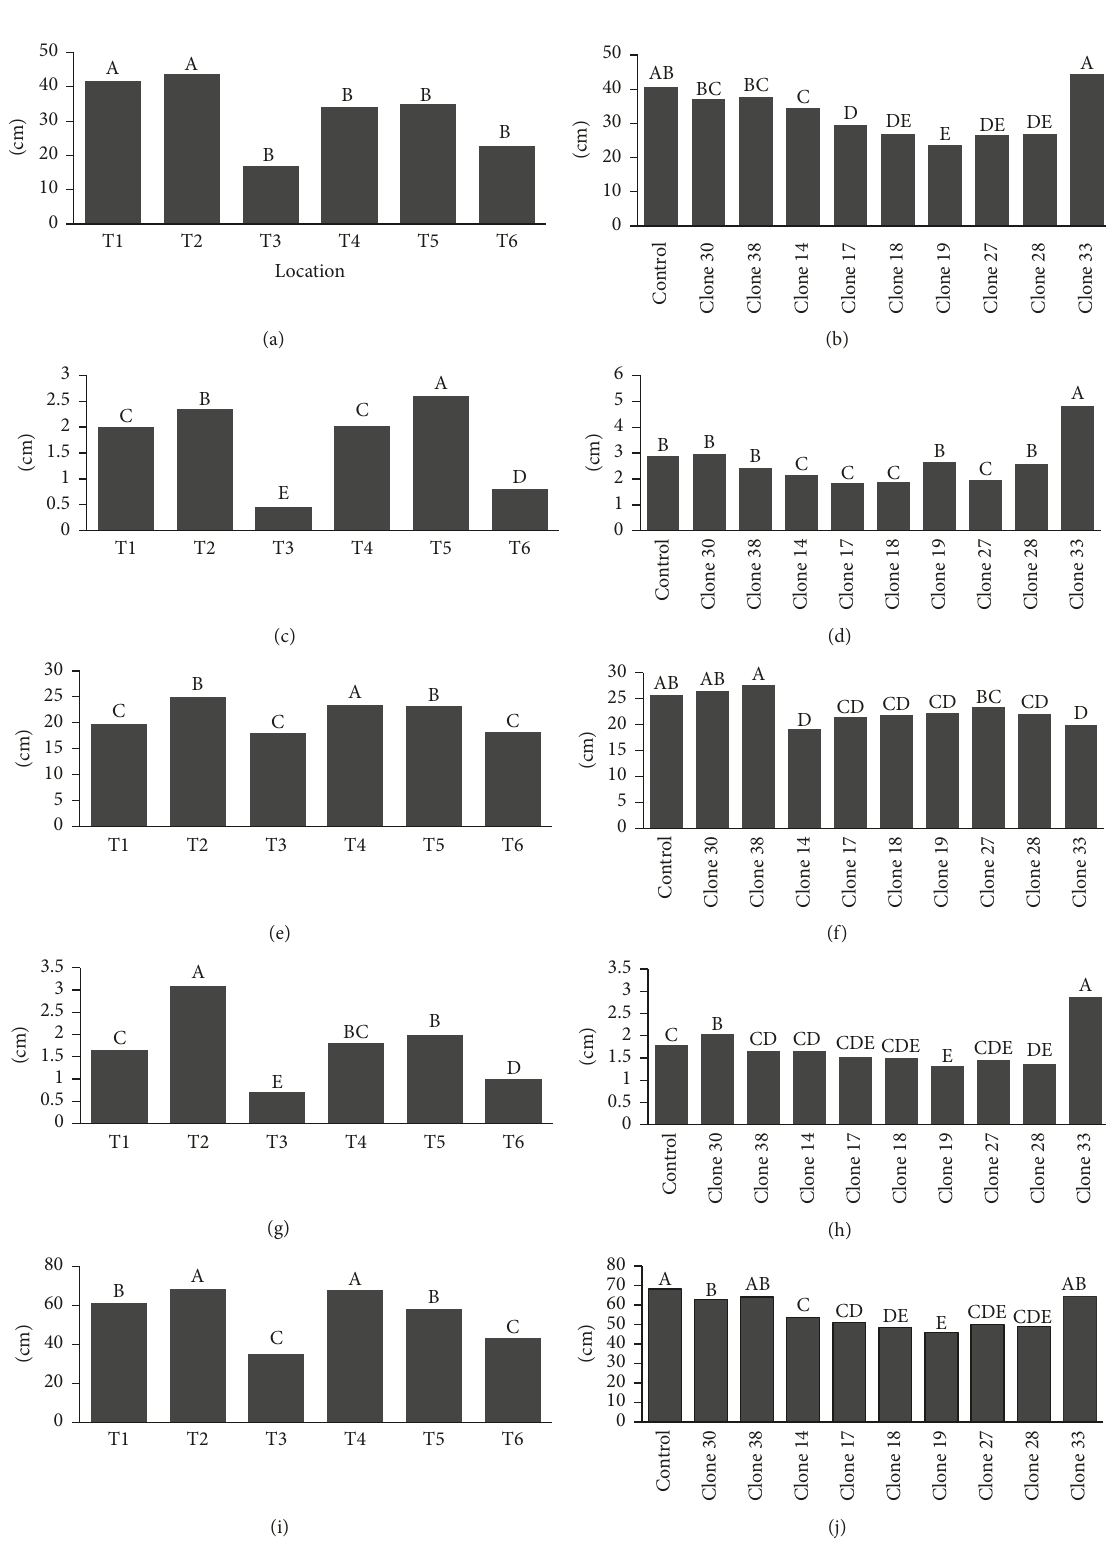
Figure 1: Agronomic traits evaluated for ten genotypes of bunching onion on six trials. (a) Leaf length by trials; (b) leaf length by genotypes. (c) leaf diameter by trials; (d) leaf diameter by genotypes; (e) pseudostem length by trials; (f) pseudostem length by genotypes; (g) pseudostem diameter by trials; (h) pseudostem diameter by genotypes; (i) plant height by trials; (j) plant height by